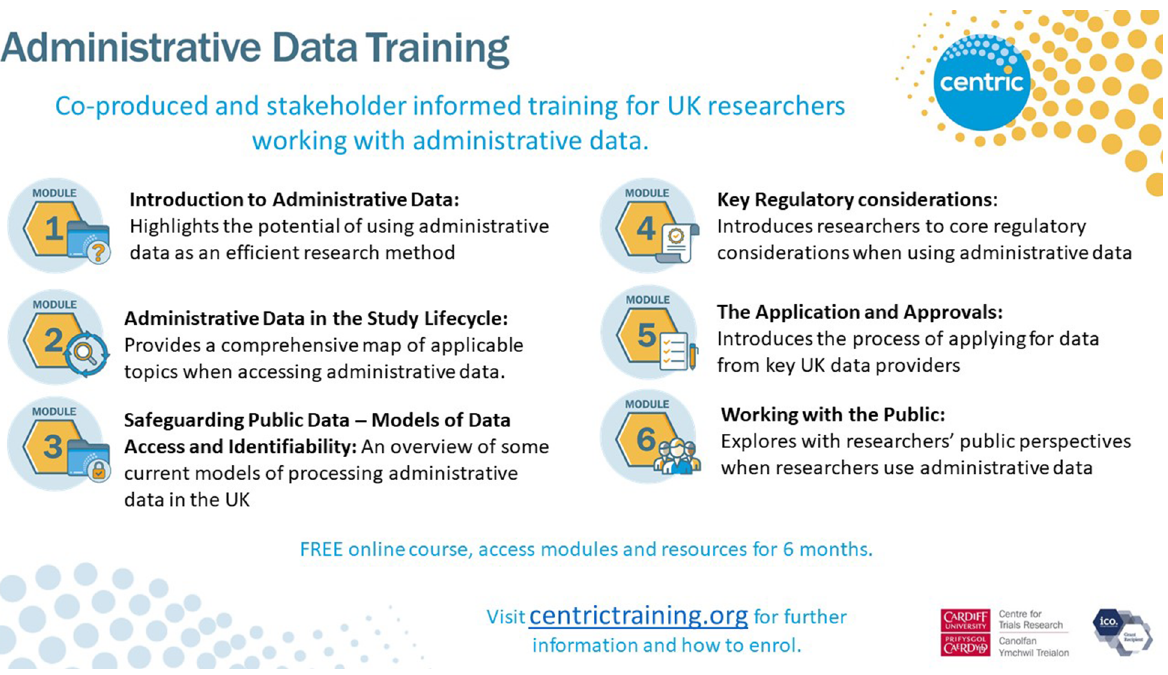
Figure 1: CENTRIC training module